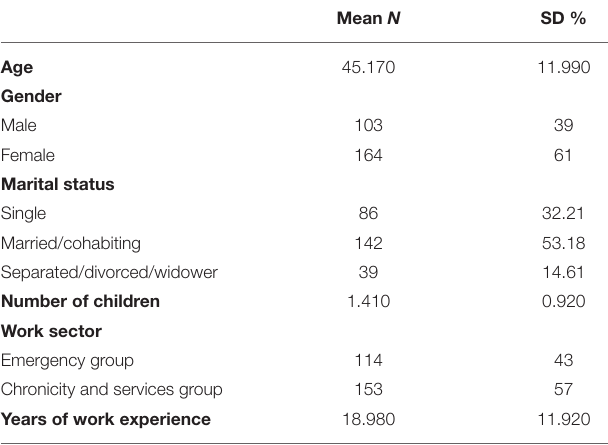
TABLE 1 | Socio-demographic and work characteristics of the